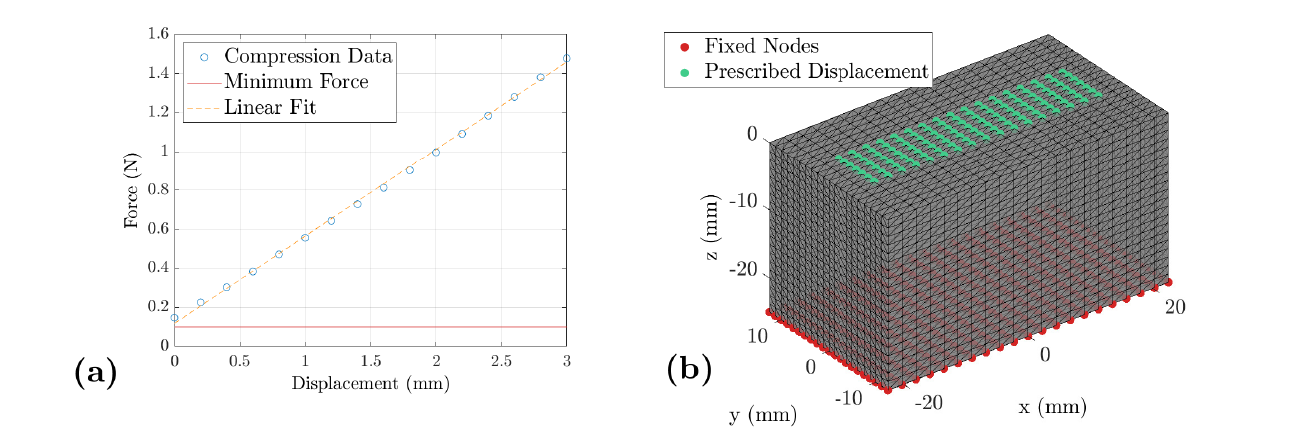
Figure 3. Boundary conditions for the finite element optimization: ( a ) The measured load curve for a gelatin sample: The displacement of the sample surface is plotted against the compression force. Thus, the measured displacement is used as input for the FE model. The defined contact force of 0.1N and a linear fit are additionally indicated. ( b ) The FE model: The red dots indicate the fixed nodes at the bottom of the gelatin sample and the green dots indicate the moving interface between transducer and gelatin. Furthermore, the green ones show the boundary on which the compressing force is measured and later used as the optimization